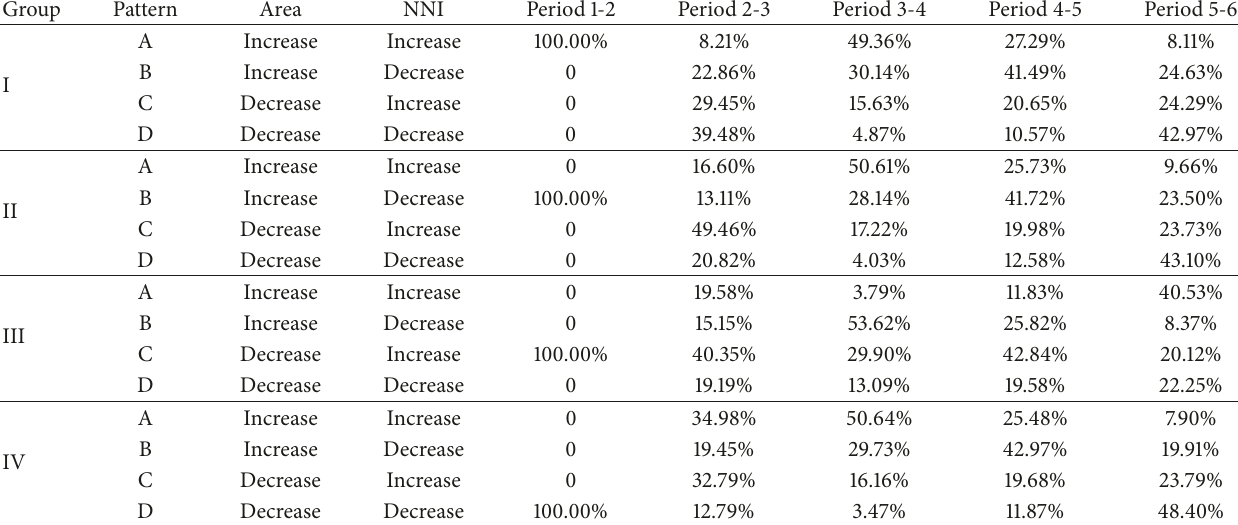
Table 3: The taxicab percentage of four patterns within each group during neighboring